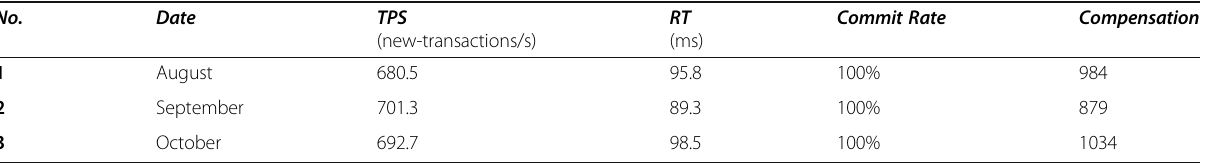
Table 8 Data consistency experiment data